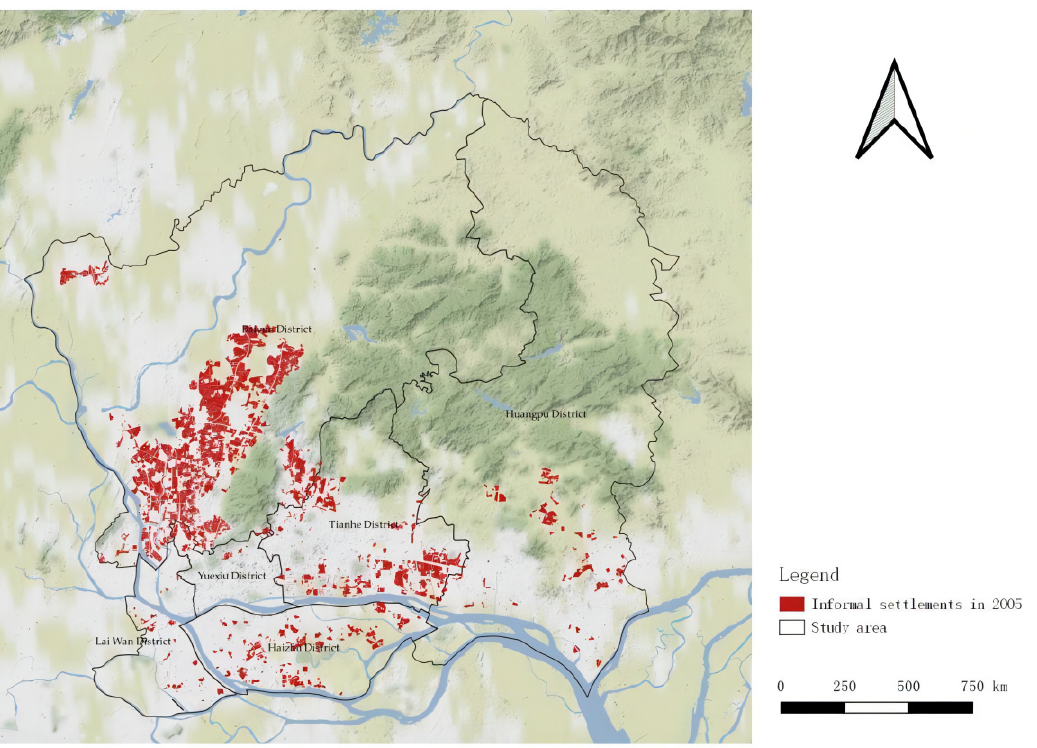
Figure 6. The spatial distribution characteristics of informal settlements in 2005. Source: drawn by the authors. The background image is from the Stamen map.